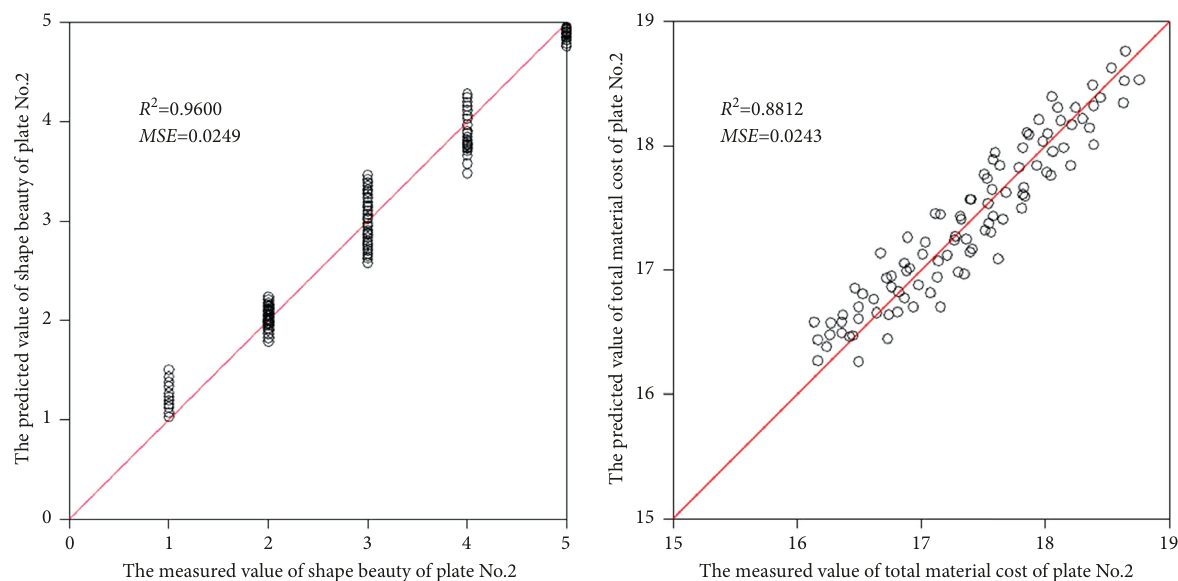
Figure 15: Fitting situation of the training samples in plate no.